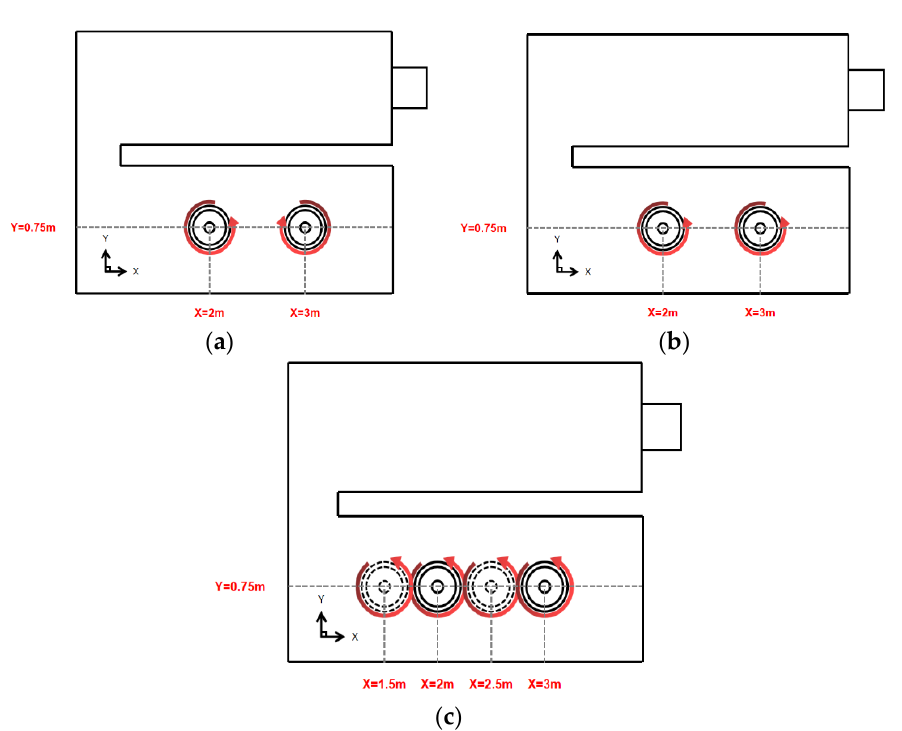
Figure 3. Three different burner arrangement modes and relative swirl direction. ( a ) Symmetrical arrangement of burners with reverse swirl. ( b ) Symmetrical arrangement of burners with same direction flow. ( c ) Burner-staggered arrangement with same direction flow.